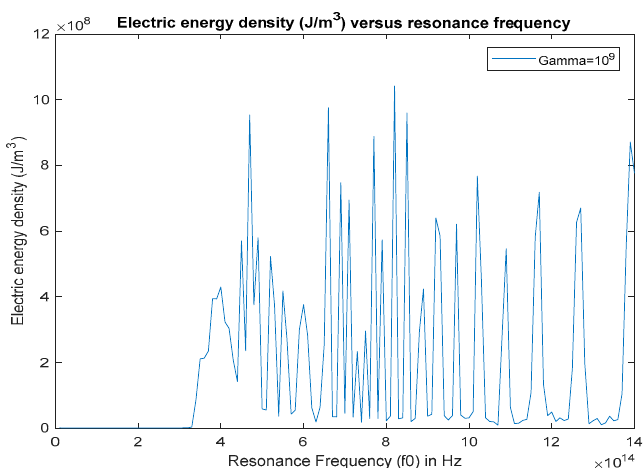
Figure 6. Maximum electric energy density inside the cavity at x = 5.73 µ m for 0 < t < 30 ps, versus f 0 .